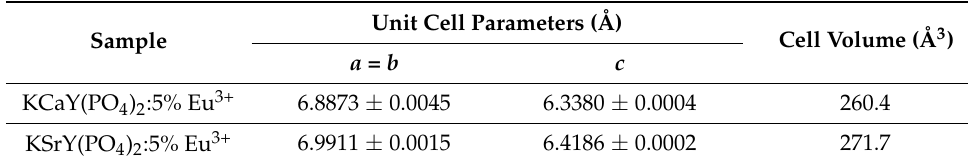
Table 1. The unit cell parameters and the cell volume of the K Me Y(PO 4 ) 2 :5% Eu 3+ powders sintered at 1000 ◦ C.